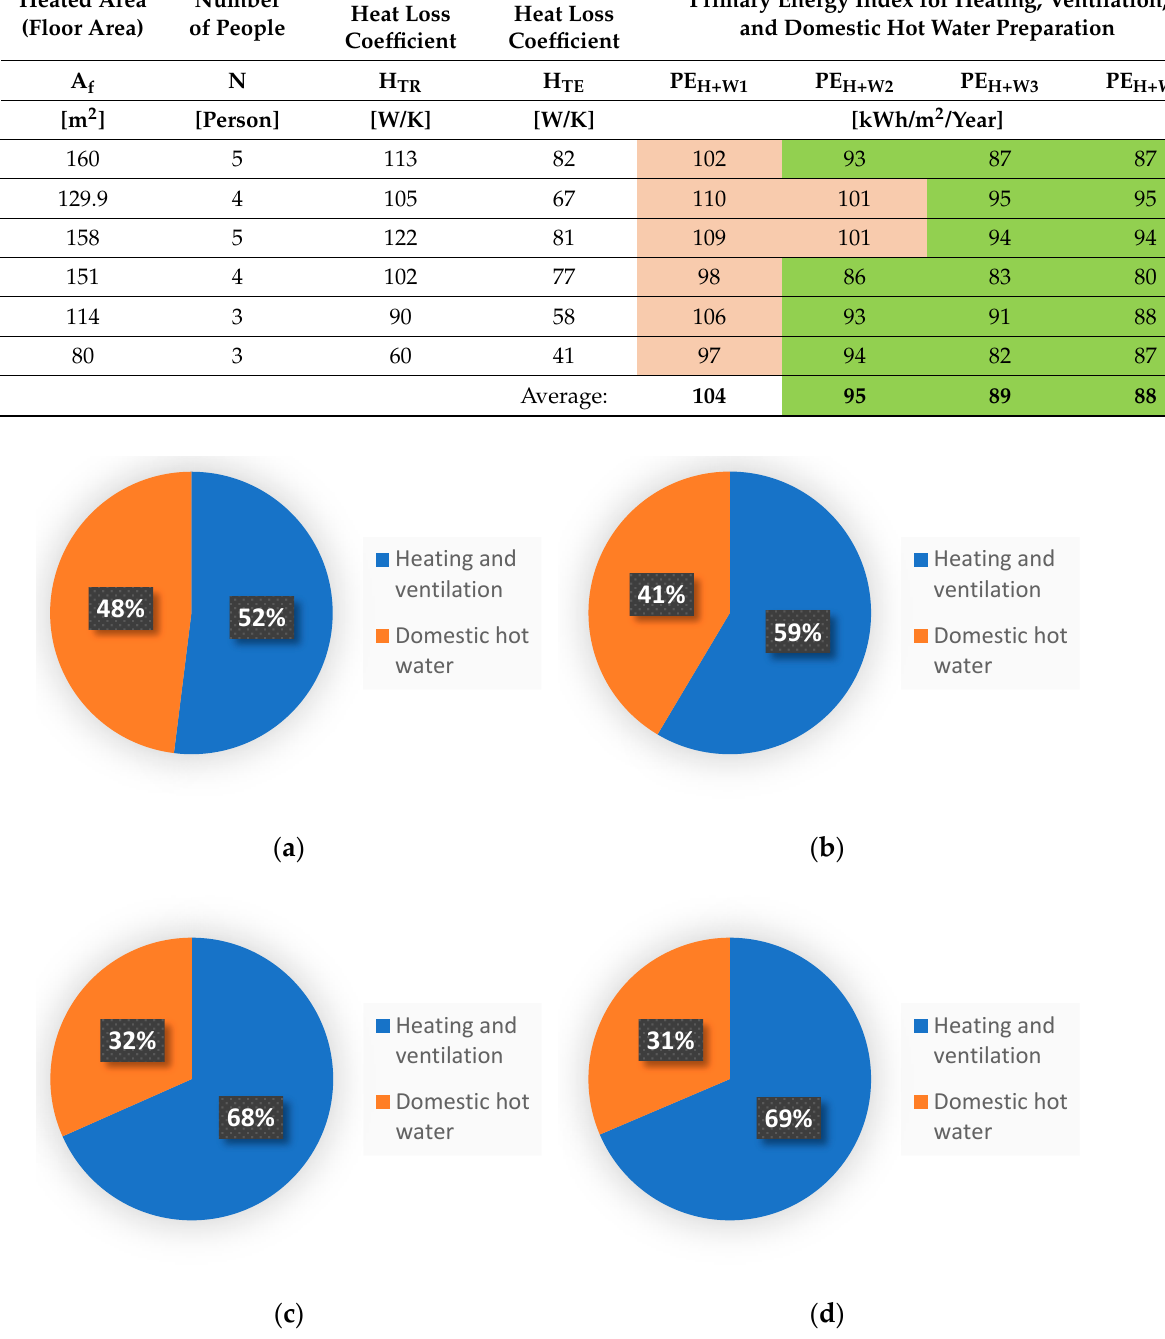
Figure 7. The share of primary energy demand used for DHW and heating/ventilation in new buildings. Calculations were performed to meet the requirement of PE < 70 kWh/m 2 /year using four different DHW consumption indicators. (a) DHW consumption: 1.4 dm 3 /m 2 /day; (b) DHW consumption: 35 dm 3 /person/day; (c) DHW consumption: 0.85